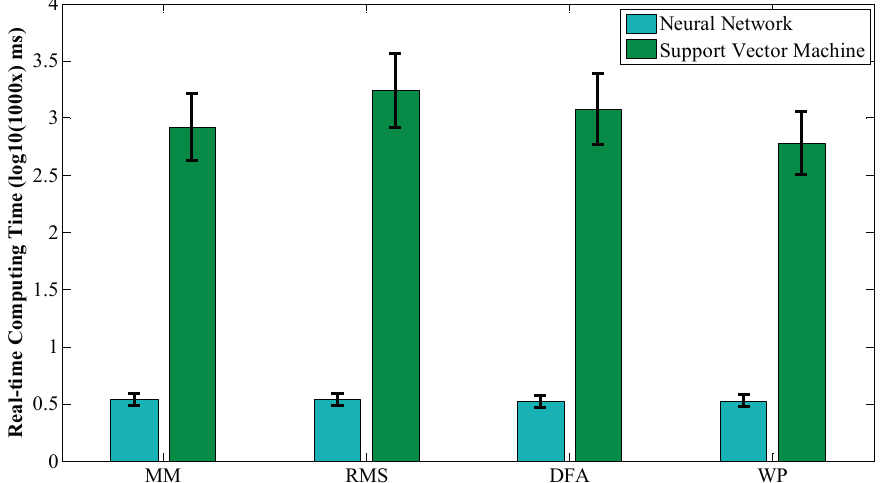
Figure 5. Time consumption of on-line testing process. Blue bars show the average computing time using NN with different features on all the subjects. Green bars show the results with